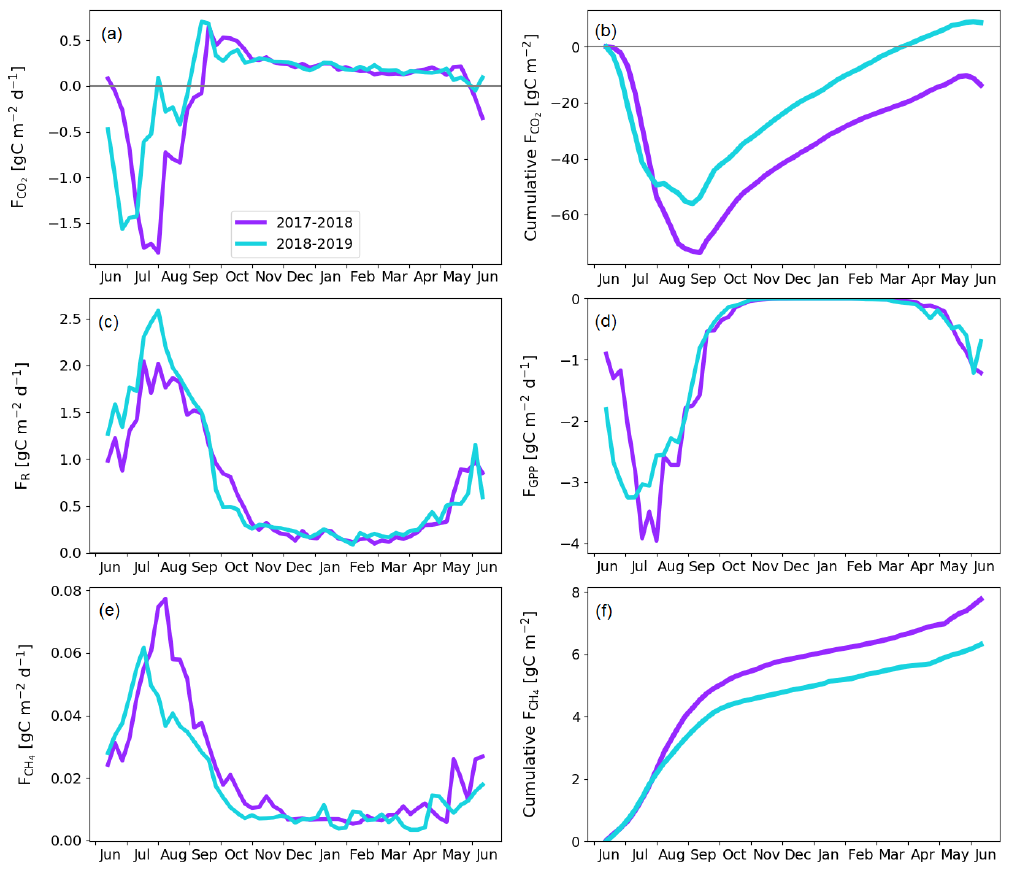
Figure 9. Fen gap-filled fluxes. Weekly averaged CO 2 (a) , ER (c) , GPP (d) , and CH 4 (e) flux. Cumulative CO 2 (b) and CH 4 (f) flux.